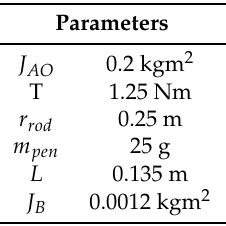
Table 1. Inverted pendulum test setup